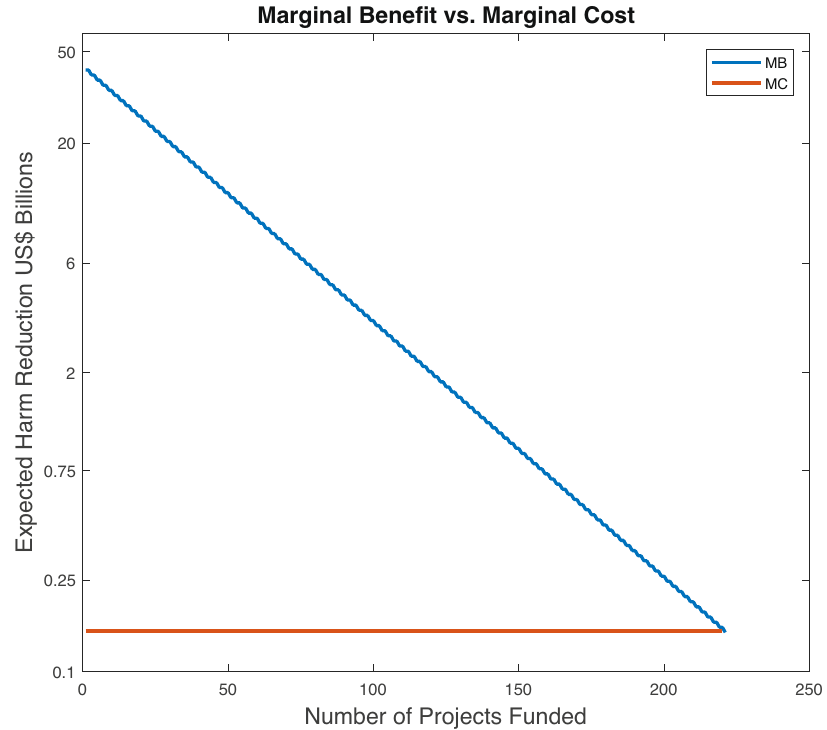
Fig. 1 Calibrated model. The vertical axis uses a log scale. Monetary values in 2020 USD. Table 1. Optimal